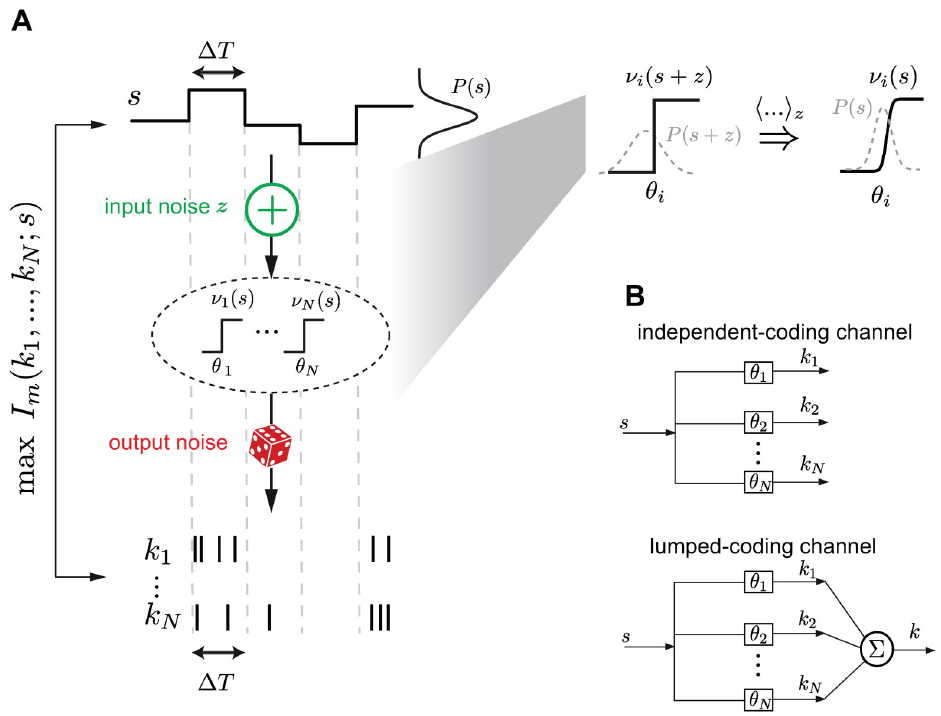
Fig 1. Stimulus encoding with a population of neurons in the presence of input and output noise. A . Framework: A static stimulus s (top) is encoded by a population of spike counts { k 1 , ... k N } (bottom) in a coding time window Δ T . The stimulus is first corrupted by additive input noise z and then processed by a population of N binary nonlinearities { ν 1 , ... ν }. Stochastic spike generation based on Poisson output noise corrupts the signal again. Thresholds { θ 1 , ... , θ N of the nonlinearities are optimized such that the mutual information I m ( k 1 , ... , k N ; s ) between stimulus and spike counts is maximized. Inset: Introducing additive input noise and a binary nonlinearity can be interpreted as having a sigmoidal nonlinearity after the input noise is averaged, h ... i z . Shallower nonlinearities result from higher input noise levels. B . Two different scenarios of information transmission: In the independent-coding channel each neuron contributes with its spike count to the coding of the stimulus, while in the lumped-coding channel all spike counts are added into one scalar output variable that codes for the